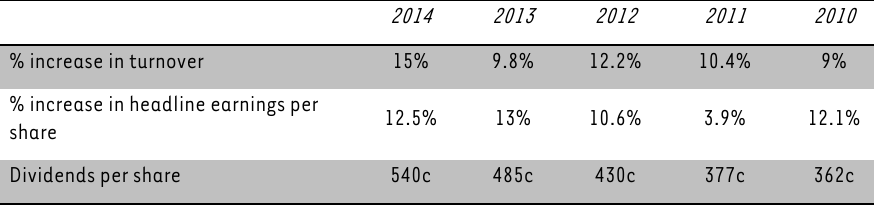
TABLE 2: SPAR performance statistics from 2010 to 2014